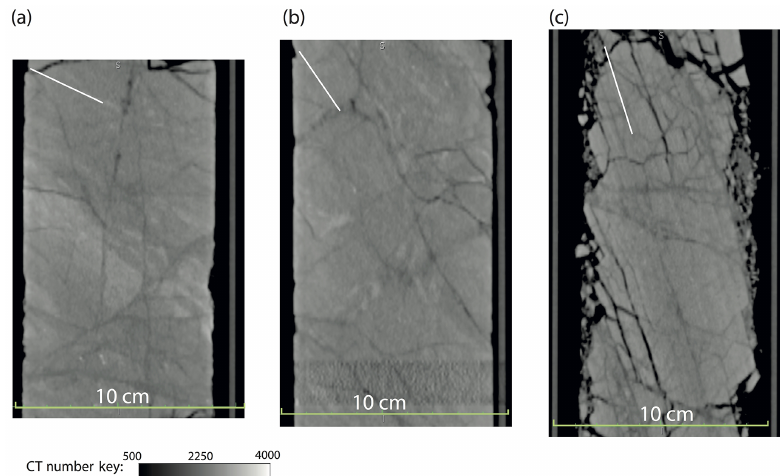
Figure 6. The relationship between foliation and fracture orientations in Alpine Fault ultramylonite, as observed in 2-D CT image slices of DFDP-1 drill core. Intervals are (borehole, core section and run, depth interval) (a) DFDP-1A 55-1 75.45–75.62m, (b) DFDP-1B 35- 1 102.49–102.64m, and (c) DFDP-1B 25-2, 44.80–45.20m. In panels (a) and (b) , fractures tend to cross-cut the ultramylonitic foliation (orientation represented by white line in the top left corner of each image). (c) Fractures show a greater preference to be aligned parallel to the foliation. Note that panel (c) was previously shown in Williams et al. (2016) and is not included in the reorientation analysis in Fig. 5, as there was no BHTV imagery for this